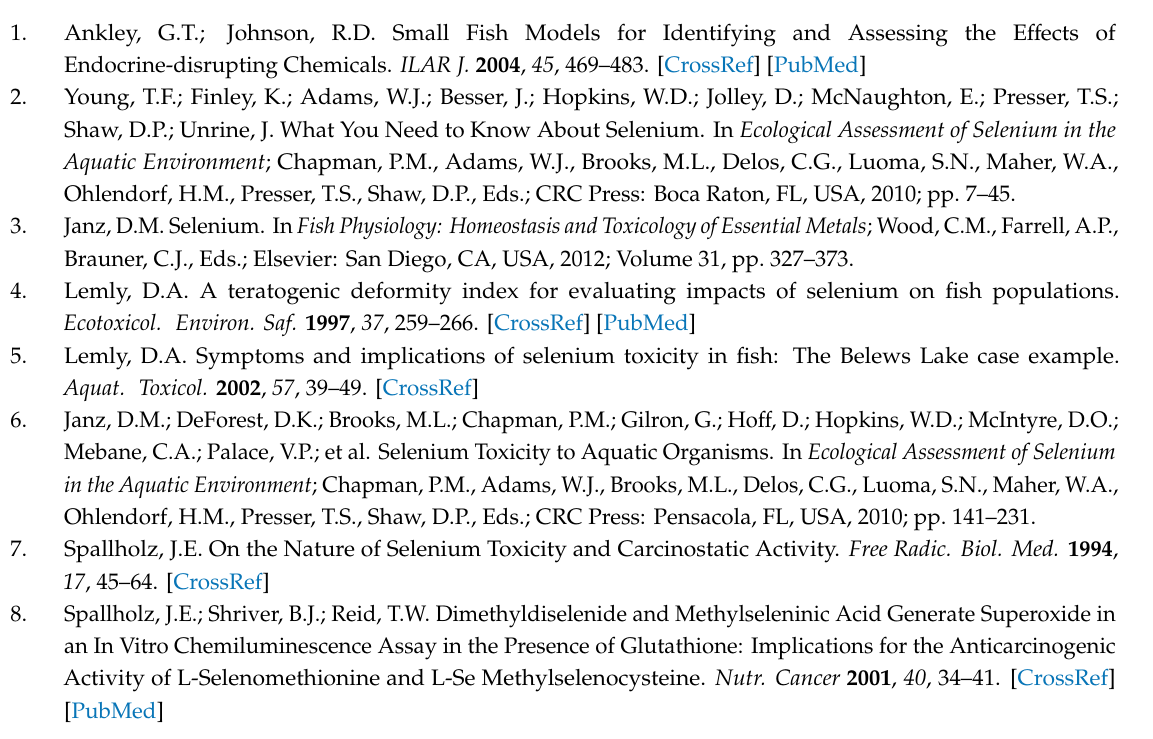
Figure S9: Mean ( ± SE) fold change in gene expression in zebrafish exposed via embryo aqueous exposure to facility water (control), tBHQ, tBOOH, and two concentrations of SeMet (25 and 125 µ g Se / L) either with (tBOOH-t, 25-t, 125-t) or without (tBOOH, 25, 125) a tBHQ pre-treatment. Asterisks represent significant di ff erences compared